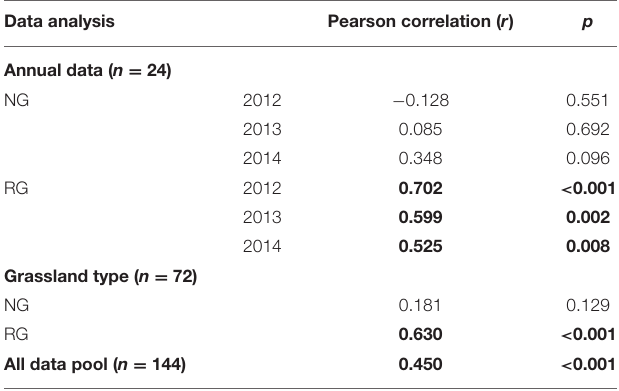
TABLE 2 | Correlations between plant community total and aboveground biomass in the natural (NG) and restored (RG) alpine grasslands around Qinghai Lake Basin.